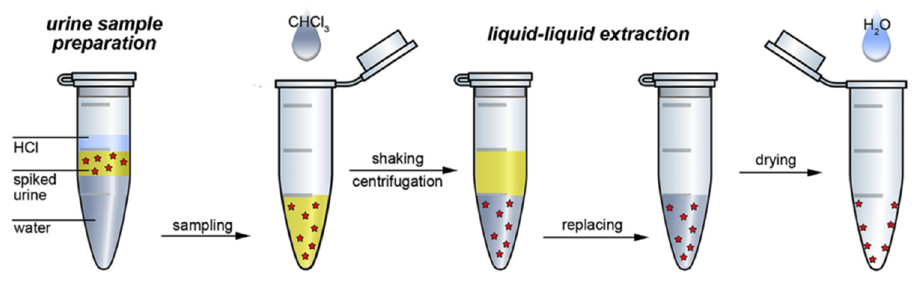
Figure 4. An example of urine sample preparation and LLE procedure. Reproduced with permission from [87]. Copyright 2022 Elsevier.